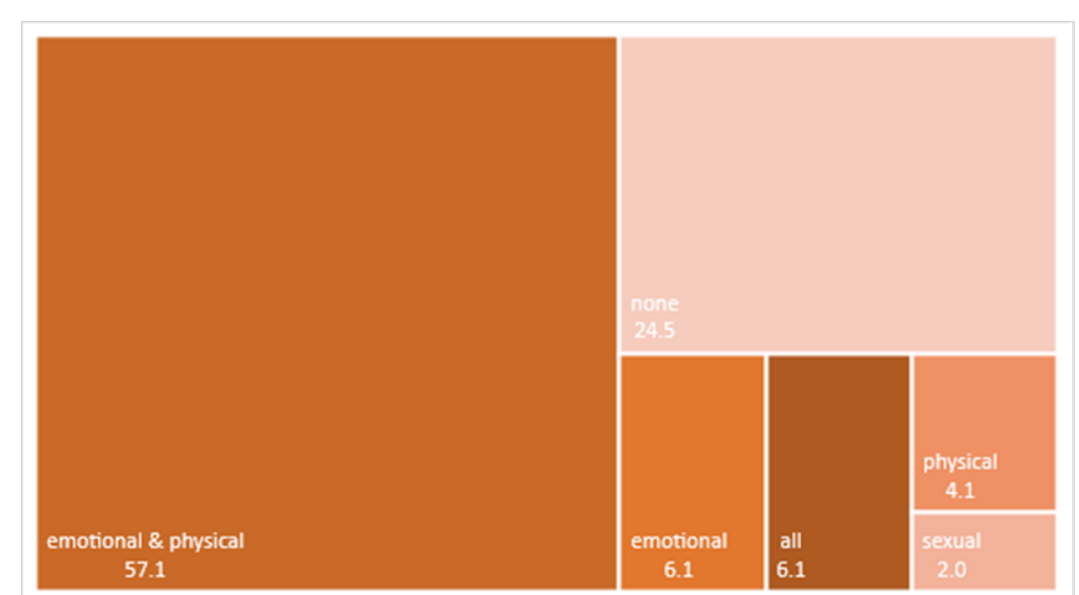
Figure 2. Percentages of profiles of (ex-) partners according to the type of violent behaviour they reported they had suf- fered.